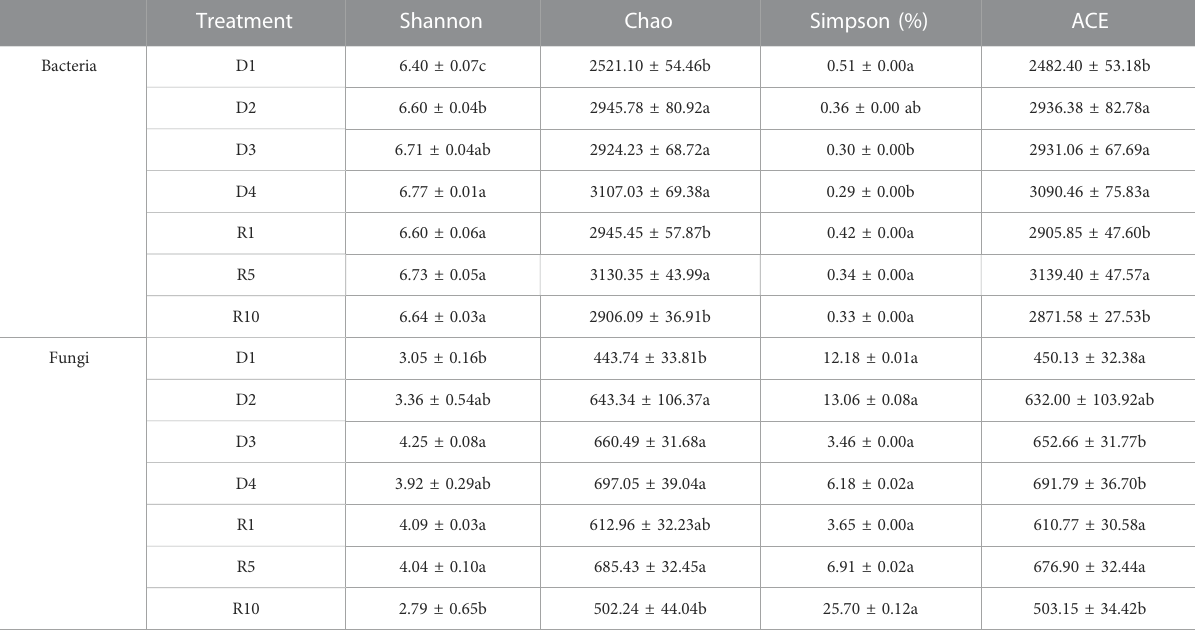
TABLE 4 Community diversity of bacteria and fungi at different stages of degradation stages and recovery